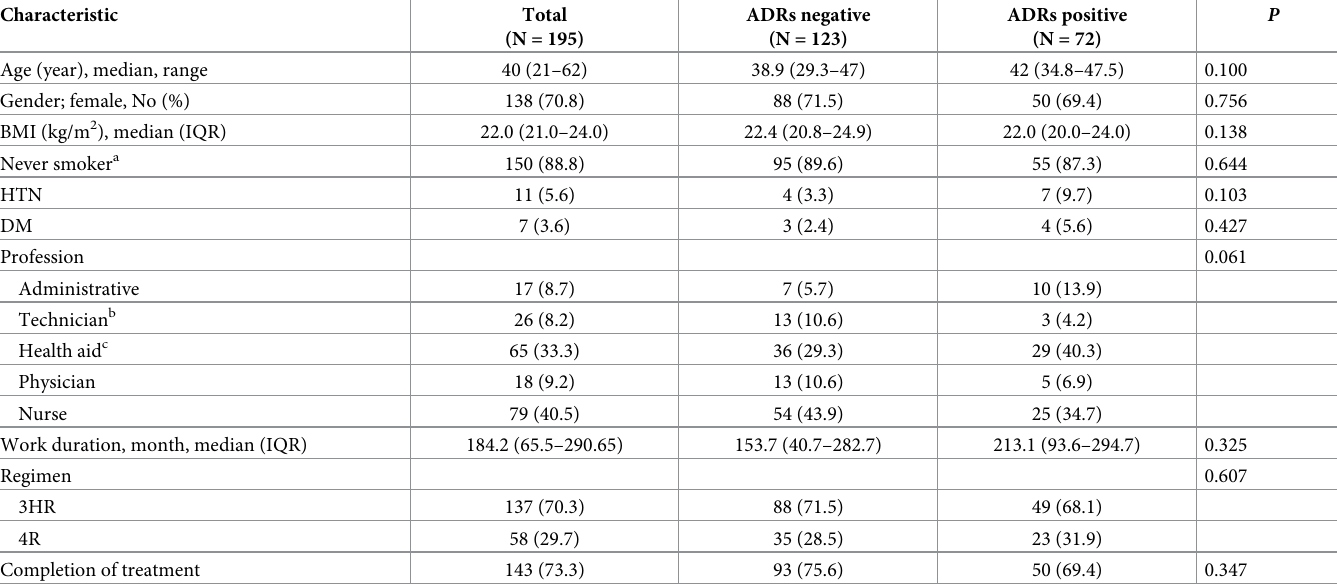
Table 4. Comparison of the characteristics between HCWs who experienced ADRs or